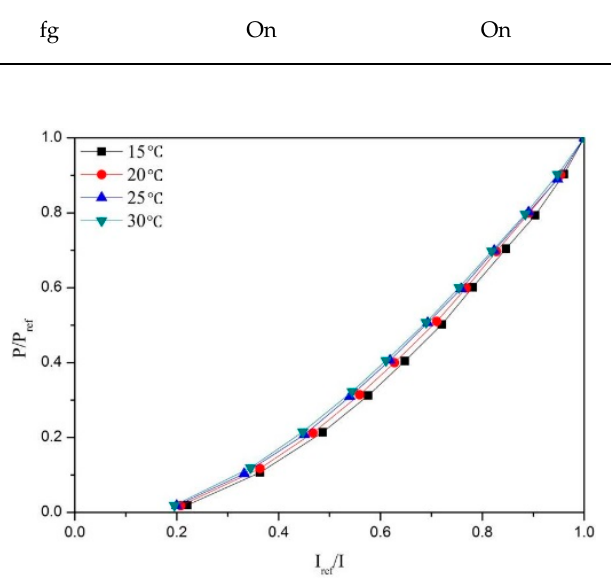
Figure 3. Pressure sensitive paint (PSP) calibration curve.